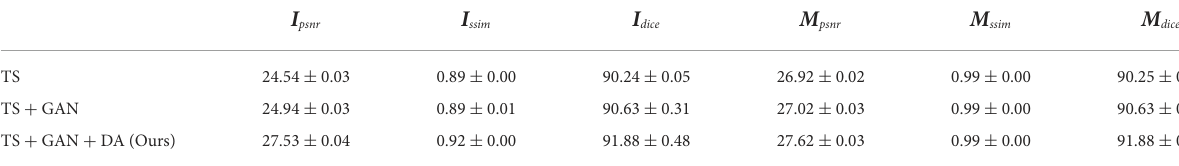
TABLE 7 Ablation study of our algorithm with three main contributions, time-series (TS), GAN, and the proposed time-series data augmentation